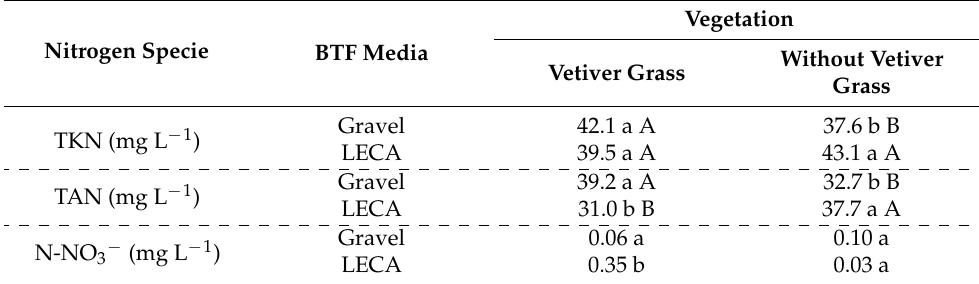
Table 5. Concentrations (mg L − 1 ) of TKN, TAN and N-NO 3 − in BTFs effluents. For TKN and